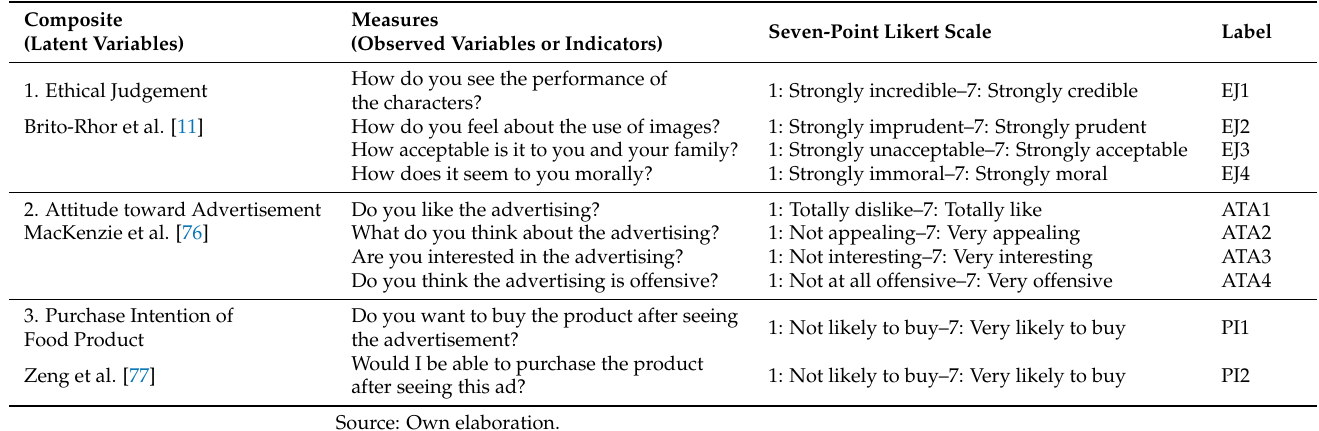
Table 1. Composite (not observed variable) and measures (observed variables).